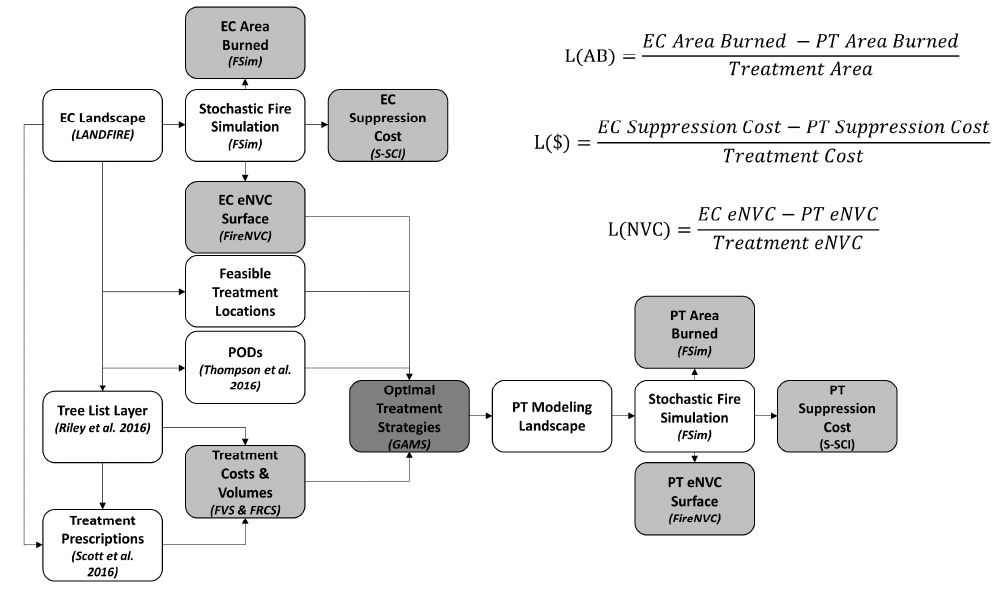
Figure 2. Optimization-simulation modeling workflow along with leverage formulas; boxes highlighted in grey form the basis for leverage calculations. EC = existing condition; PT = post-treatment; eNVC = expected net value change; L(AB) = leverage as a function of area burned; L($) = leverage as a function of costs (U.S. dollars); L(NVC) = leverage as a function of expected net value change.